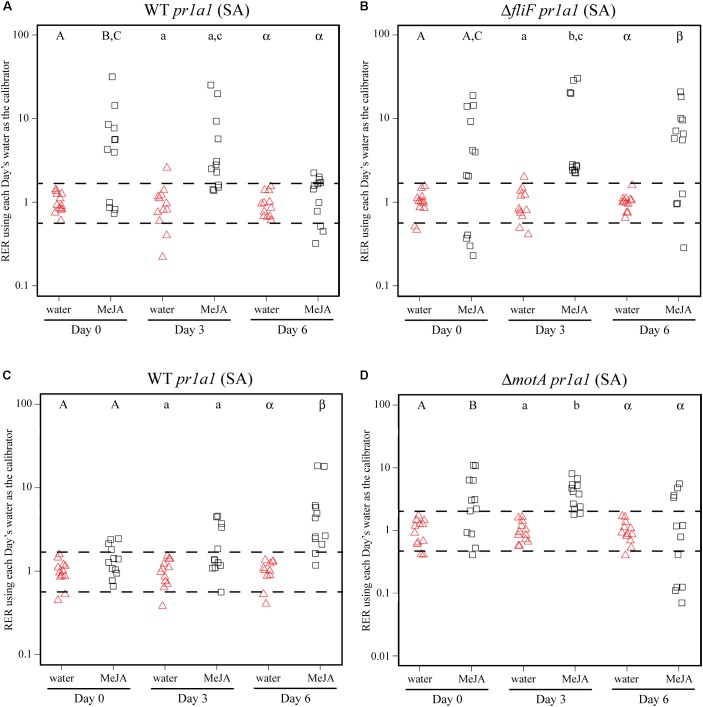
MeJA treatment and S. Typhimurium inoculation lead to activation of the SA response. Plant pr1a1 gene expression was quantified at days 0, 3, and 6 post-inoculation with wildtype S. Typhimurium (WT; A,C), the fliF::Kan mutant (B) or the motA::Kan mutant (D) for plants sprayed with water (red triangles) or MeJA (black squares) and displayed as relative expression ratios (RER) using transcription on plants treated with water as the calibrator. The fliF::Kan and motA::Kan mutants were tested in separate experiments, and the corresponding wildtype data are displayed for each experiment. The dashed line indicates a twofold change in transcription, and each symbol represents data collected from one tomato plant. Transcript levels were quantified from three biological replicates with samples taken from four plants per treatment per time point. Letters denote significant differences between treatments within a single time point in each experiment (P < 0.05).